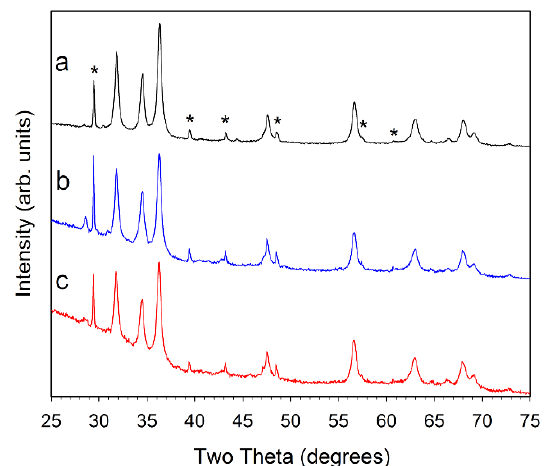
Figure 3. Powder XRD results for ( a , black) ZZ-Co(1%):ZnO; ( b , blue) ZZ-Co(5%):ZnO; and ( c , red) ZZ-Co(10%):ZnO. The major peaks for CaCO 3 are marked with a * symbol in ( a ). Small peak near 28.5° is consistent with KCl.